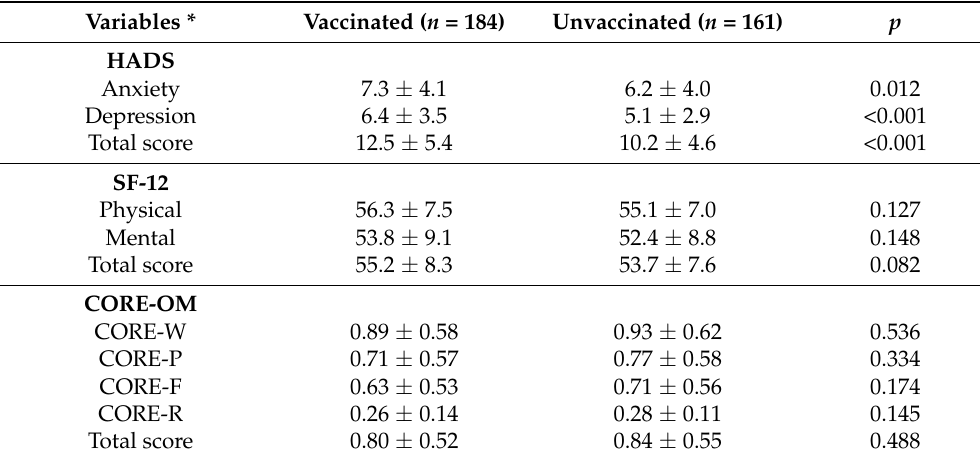
Table 3. Comparison of standardized questionnaires between vaccinated and unvaccinated pregnant women.